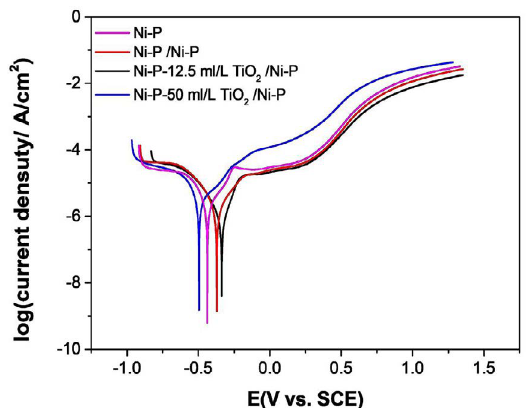
Figure 8. Potentiodynamic polarization curves of Ni-P coating and duplex Ni-P-TiO /Ni-P coatings. 2